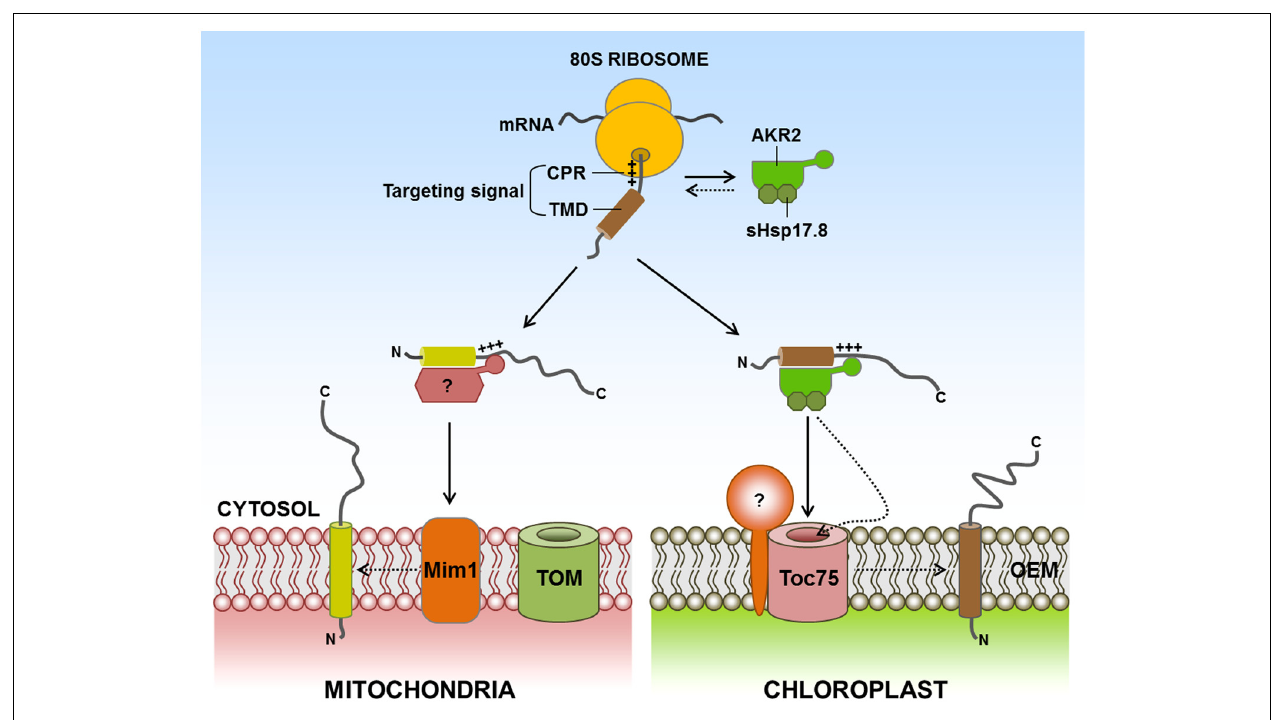
(as a dimer) binds to both AKR2 and chloroplasts. However, no cytosolic factors have been identified for targeting of mitochondrial outer membrane SA proteins. Mim1 is involved in the insertion of certain mitochondrial outer membrane SA proteins into the mitochondrial outer membrane. AKR2, ankyrin-repeat protein 2; CH, chloroplast; CPR, C-terminal positively charged flanking region; ER, endoplasmic reticulum; Mim1, mitochondrial import 1; TMD, transmembrane domain; +++ , positively charged amino acid residues; ?, postulated factor; dashed arrow, postulated